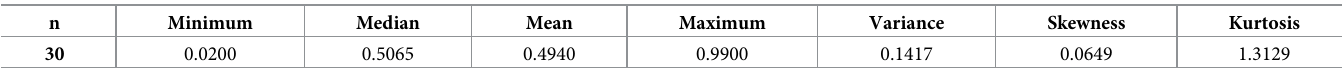
Table 7. Descriptive statistics for the data sets.